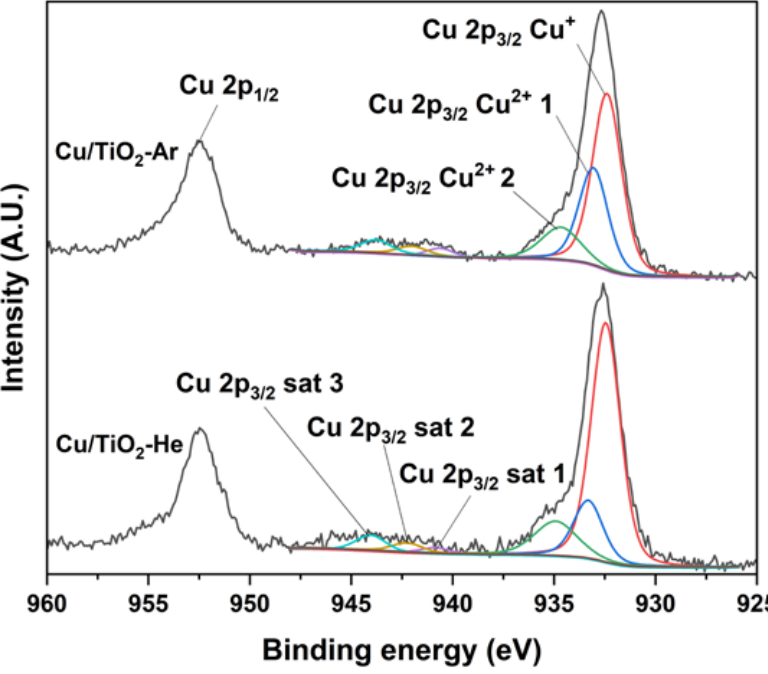
Figure 3. Cu 2p core-level spectra comparison of Cu/TiO 2 -He and Cu/TiO 2 -Ar samples. The CH 3 CH 2 • radical can react with a H • (H + + e − ) to further form C 2 H 6 in majority. The coupling of two CH 3 CH 2 • is responsible for C 4 H 10 formation, and two H • can form H 2 . According to Scandura et al. [10], traces of ethylene are formed by the reaction of CH 3 CH 2 • with h + . Hence, from Equation (1), selectivities are defined in terms of hydrocarbon (C 2 H 4 , C 2 H 6 ) to CO 2